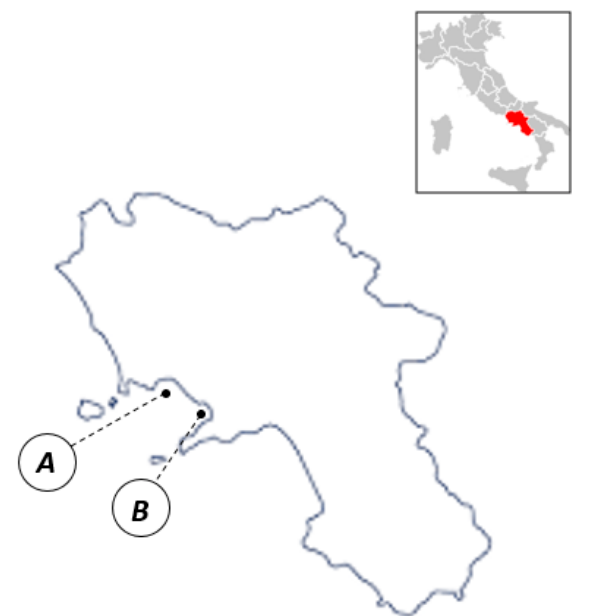
Figure 3. Map showing locations of the sampling sites: Napoli (site A) and Castellammare di Stabia (site